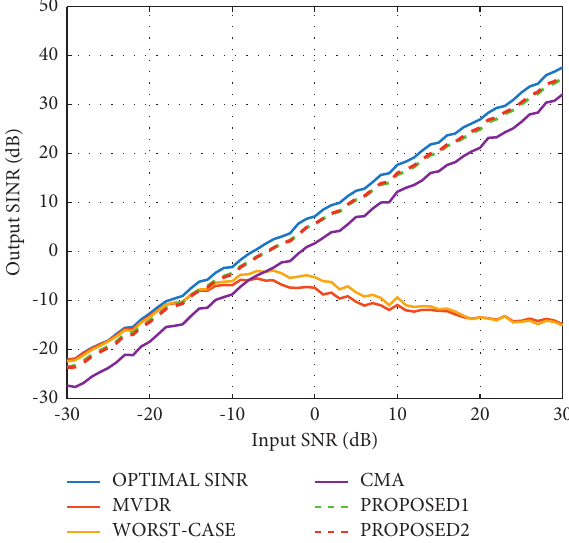
Figure 7: Fixed look direction mismatch: output SINR versus the input SNR.